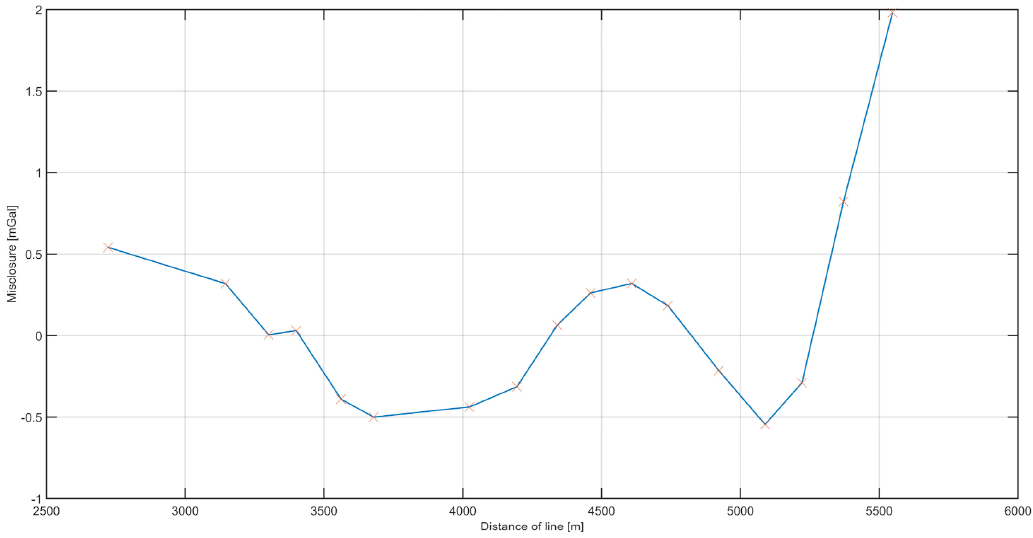
Figure 11. Distribution of di ff erences between the gravity obtained on land and that measured on a survey line. The height di ff erences have been